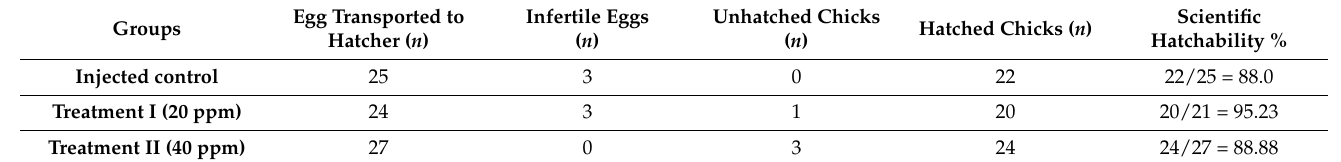
Table 5. The number of eggs transported to hatcher, infertile eggs, and unhatched and hatched chicks in each treatment from day 19 until time of